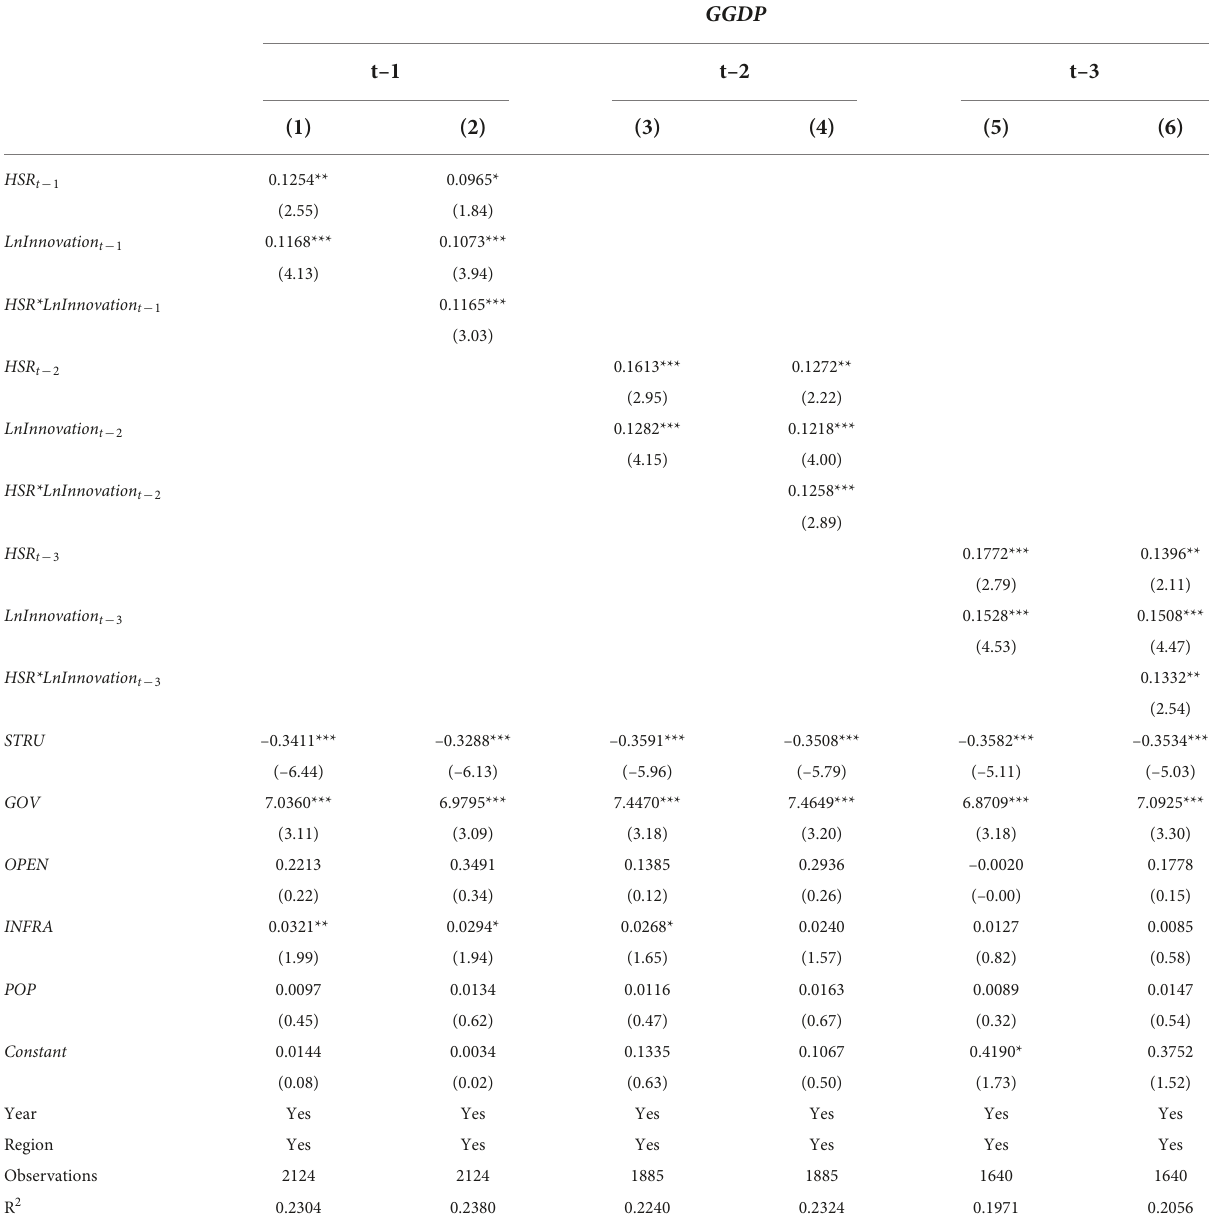
TABLE 8 The regression results of different lag